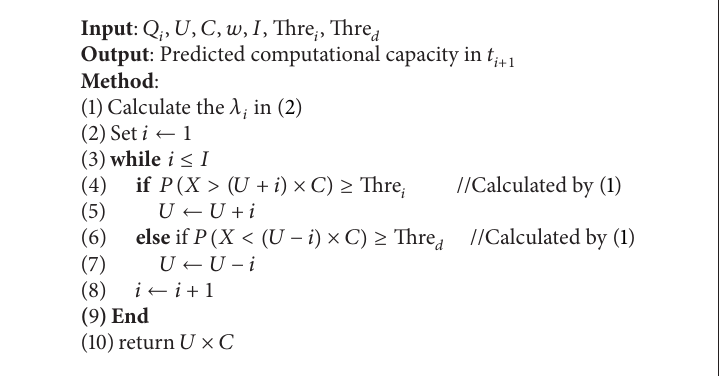
Algorithm 1: Elastic allocation.